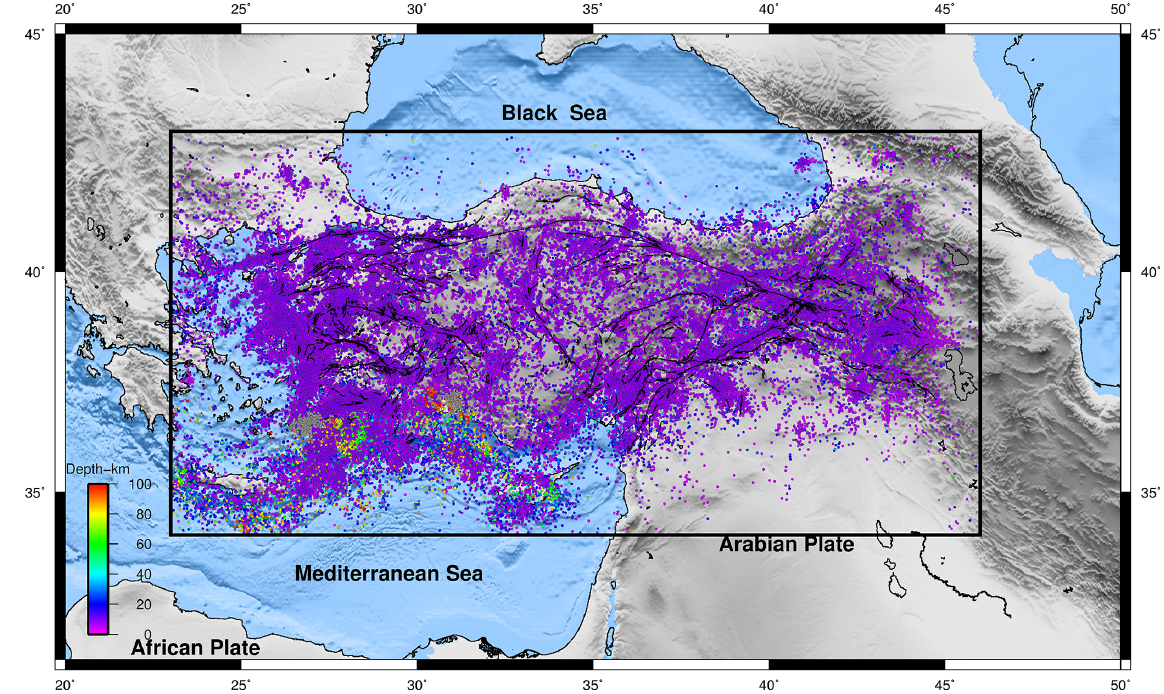
Figure 2. Seismicity map of the region with red dots representing the 174285 earthquakes recorded between 1 January 2008–31 Decem- ber 2018 and the black lines representing the active faults (Emre et al.,